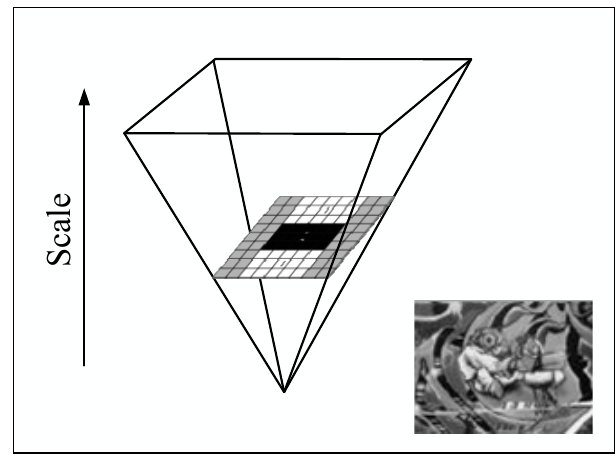
Figure 7. Scale pyramid.